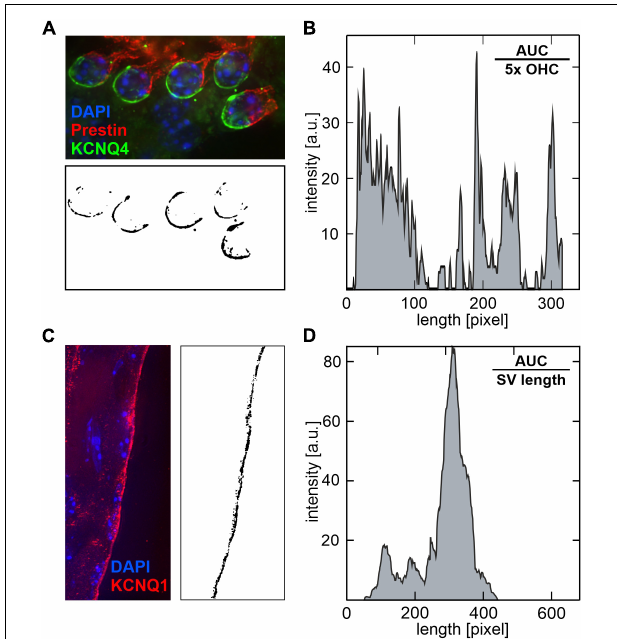
FIGURE 7 | Quantitative analysis of KCNQ4 and KCNQ1 pixel intensity profiles in cochlear cross-section fluorescence images. (A) Illustrative example of a cochlear cross-section stained with KCNQ4 (green), prestin (red) for the outer hair cell (OHC) motor protein, and DAPI (blue) for cell nuclei (upper panel). For each image, the regions of interest (ROIs) were delimited by circles around the basal pole of OHCs. The green channel (KCNQ4) was split and converted to an 8-bit grayscale image (lower panel). (B) The corresponding pixel intensity profile is shown. The pixel intensity was integrated over the processed image to obtain the area under the curve (AUC) and normalized by the number of OHCs, here 5 × , to calculate a mean KCNQ4 intensity per OHC. (C) Illustrative example of a cochlear cross-section stained with KCNQ1 (red) in the stria vascularis (SV), and DAPI (blue, left panel). ROIs were delimited by rectangles with a fixed width along the marginal layer of the SV. The red channel (KCNQ1) was split and converted to an 8-bit grayscale image (right panel). (D) The corresponding pixel intensity profile is shown. The AUC was normalized by the SV length along the y -axis to calculate a mean KCNQ1 intensity per SV width.